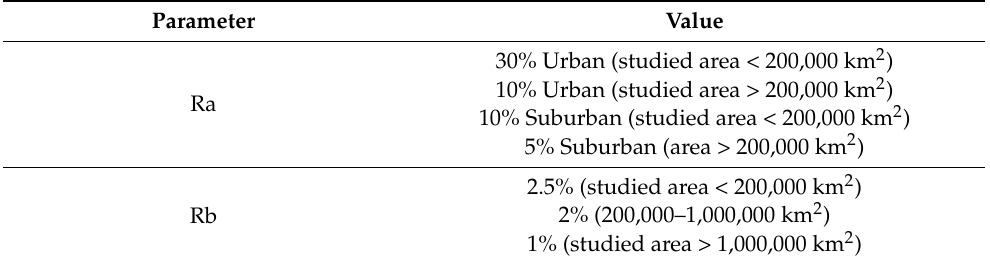
Table 3. Values for Ra and Rb of 5G for frequency the bands between 6 and 8